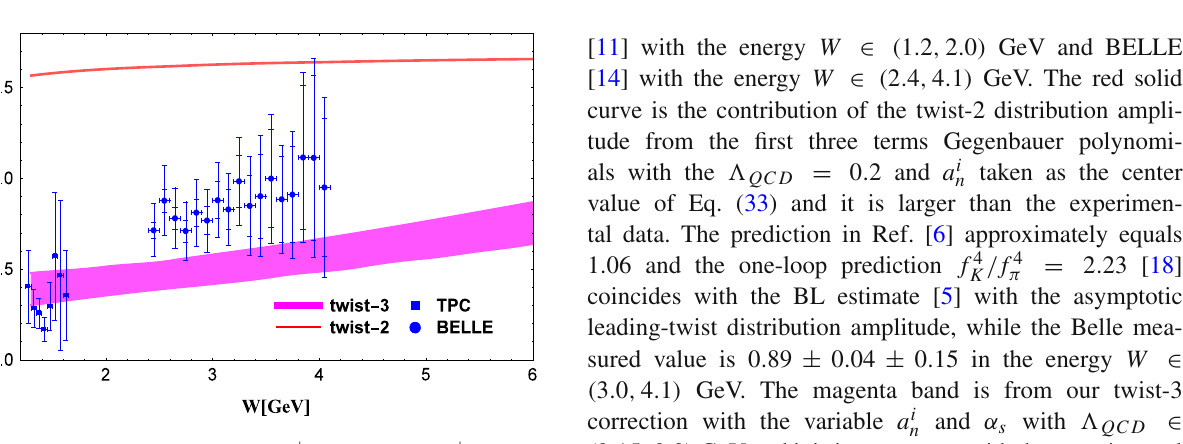
Fig. 5 Cross section ratio of γγ → π + π − to γγ → K + K − . The experimental points are from TPC [11] and BELLE